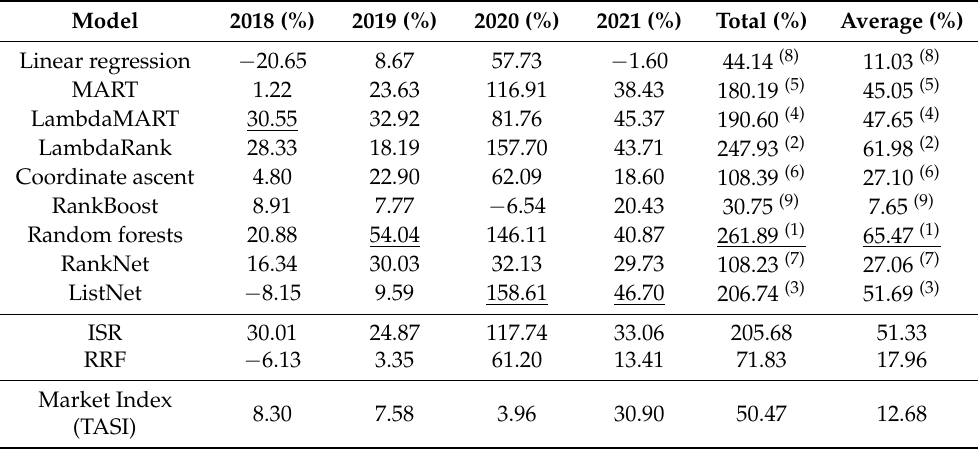
Table 7. The returns produced by each model’s simulated portfolio (top 10 selected stocks) for the four years, 2018, 2019, 2020, and 2021. Underlined values represent the models with the highest earnings. Superscript numerals in parentheses represent the rank of a model among all models based on total and average returns.